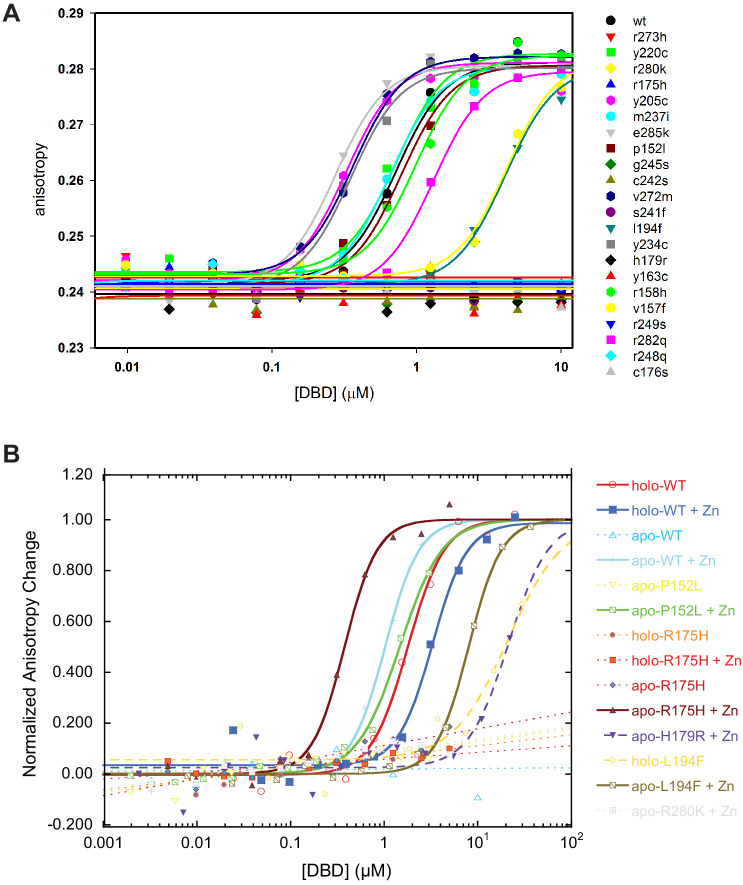
DNA-binding of p53 DBD mutants.(A) Representative fits for DBD mutants binding Cy3-labeled p53RE oligonucleotides. (B) Representative curves illustrating restoration of DNA-binding (waf1) for DBD mutants by EGTA-buffered [Zn2+]free.